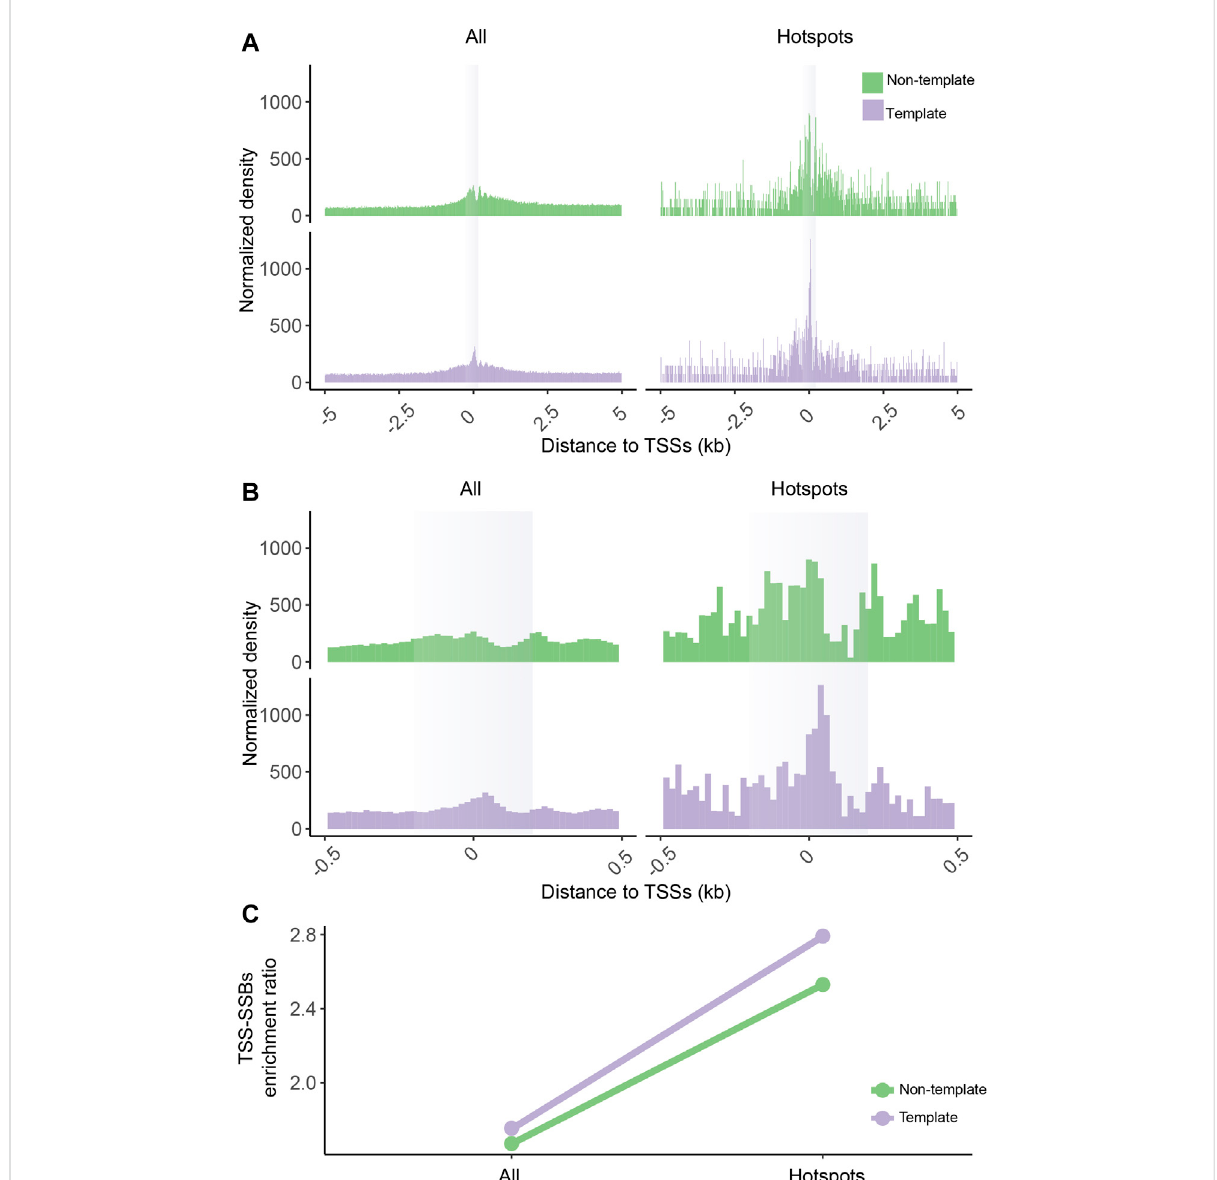
FIGURE 4 Enrichment of SSB hotspots around TSSs in SSiNGLe performed on HMW genomic DNA isolated from K562. Aggregate plots of the normalized densities (Y-axes) of the positions of all SSBs or hotspots on the template or non-template strands within ±5,000 bp (A) or ±500 bp (B) of the TSSs. (A – B) The opaque vertical rectangles represent the ±200 bp areas around the TSSs. (C) The TSS-SSBs enrichment ratios (Y-axes) for all breaks and hotspots on either template or non-template